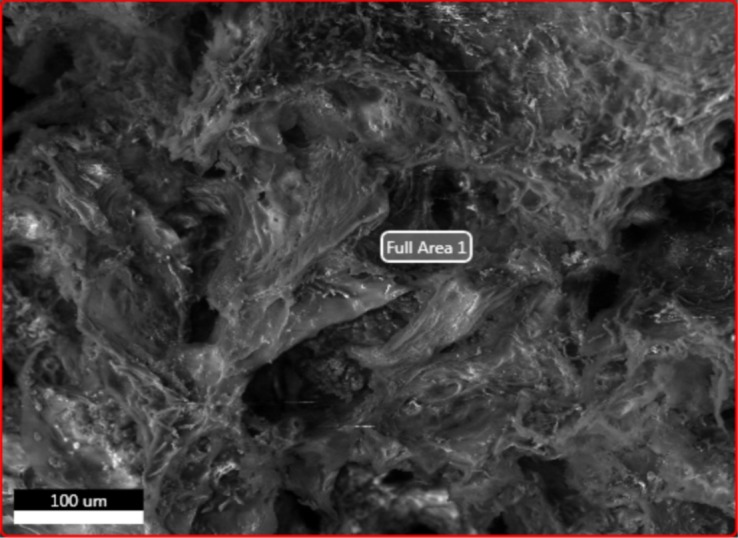
Electron image of demineralised Pleistocene-Holocene shark tooth full area 1 EDS analysis.